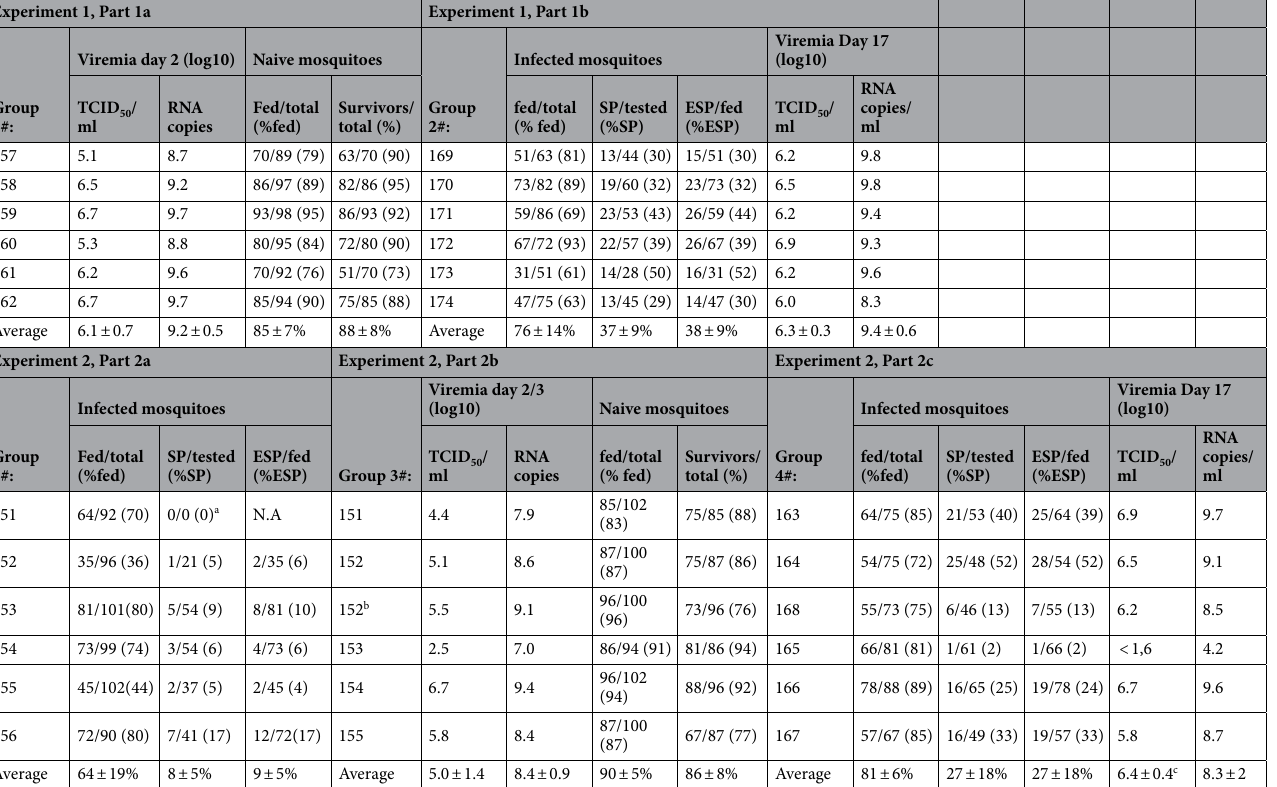
Table 1. Quantification of transmission parameters. In Experiment 1 (Part 1a), lambs from Group 1 (n = 6, blue) were IV-inoculated with RVFV on day 0. When pyrexia was measured on day 2, Ae. aegypti mosquitoes were allowed to take a blood meal. Viremia levels on this day were determined by RT-qPCR and virus isolation using plasma samples. In Experiment 2 (Part 2a), mosquitoes were infected via membrane feeding on a RVFV-spiked blood meal. After 11 days incubation, the mosquitoes were allowed to feed on lambs of Group 3 (day 0), after which the presence of RVFV in mosquito saliva samples was determined. When pyrexia in lambs of Groups 1 and 3 was noted on day 2 or 3, naive mosquitoes were placed on the lambs and viremia levels on this day were determined by RT-qPCR and virus isolation using plasma samples. The total numbers of engorged mosquitoes (fed) and the total numbers of mosquitoes used for feeding (total) are indicated, as well as the percentages fed (%fed). Engorged mosquitoes were maintained in an insect incubator for 12–13 days. After this incubation period, surviving mosquitoes were allowed to feed on naive lambs (Groups 2 and 4). The presence of RVFV in mosquito saliva samples was determined by virus isolation on Vero cells after feeding on the lambs. Arrows indicate the lambs between which RVFV was transmitted. The numbers of saliva-positive mosquitoes are indicated (SP) as well as the numbers of mosquitoes tested (tested) and the percentage of saliva-positive samples (%SP). Because not all mosquitoes survived the incubation period, the expected number of saliva positives (ESP) was extrapolated by multiplying the %SP x fed. Titers of infectious virus and RNA copies in the blood of the lambs from Groups 2 and 4 at peak viremia (experimental day 17) are also indicated. N.A., not applicable. a This lamb recovered early from sedation and violently responded to the placement of the cardboard box, resulting in mortality of all blood-fed mosquitoes. b Lamb #156 was not included in Experiment 2, Part b, as this lamb succumbed to the infection before mosquitoes could feed. The corresponding mosquitoes were allowed to feed on lamb #152 on day 3. c No infectious virus was detected in plasma of lamb #165. This sample was therefore not included when calculating the average viremia